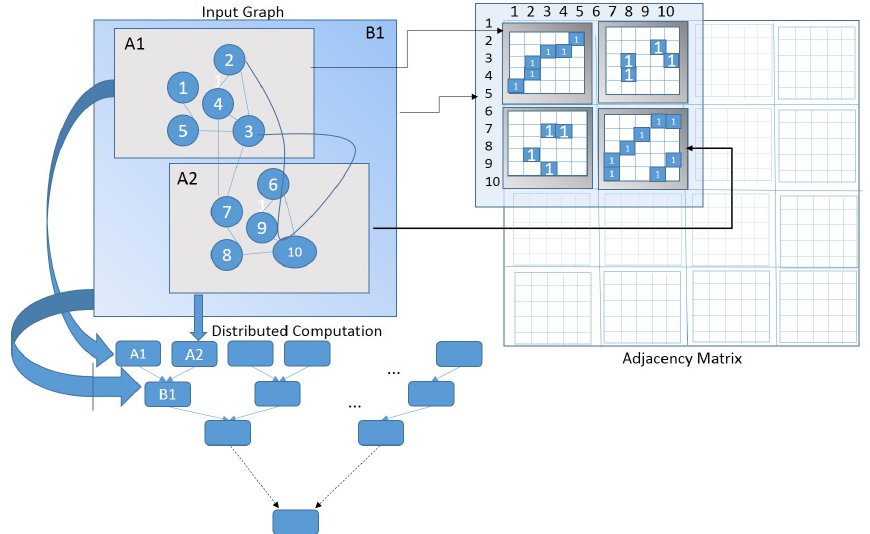
Figure 2. Local solution: Site A 1 is trained with the first five elements { b 1 , b 2 , . . . , b 5 } to return the solution for A [ 1,5;1,5 ] . Similarly, A 2 uses the successive elements { b 6 , b 7 , . . . , b 10 } for A [ 6,10;6,10 ] . The best chromosomes from A 1 and A 2 initialize B 1’s population, which, in turn, is trained to provide feasible solutions for A [ 1,10;1,10 ]